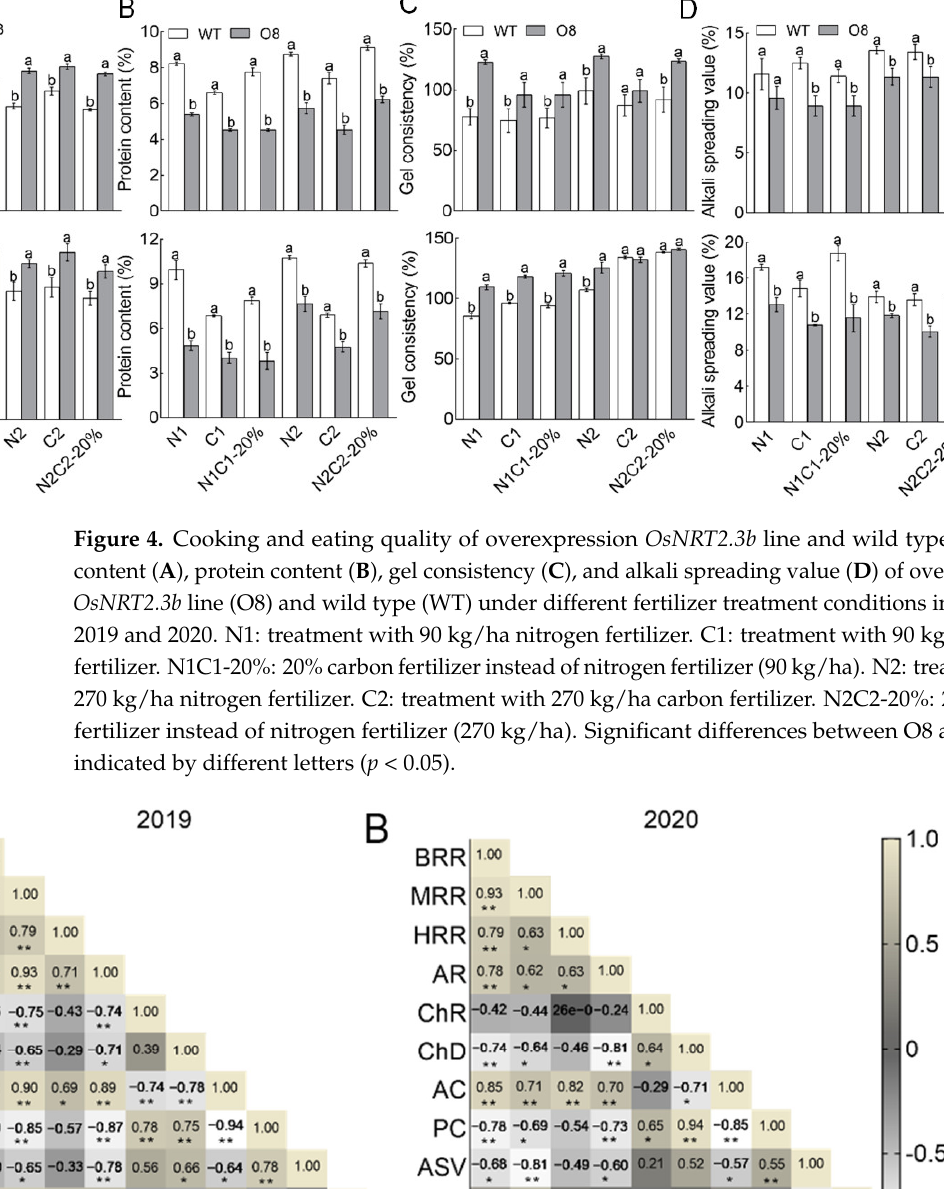
Figure 6. Hierarchical clustering of quality indicators of O8 and WT under different fertilizer treat- ments. Hierarchical clustering of quality indicators of O8 and WT under different fertilizer treat- ment in 2019 ( A ) and 2020 ( B ). BRR, brown rice rate; MRR, milling rice rate; HRR, head milling rice rate; AR, aspect ratio; ChR, chalky rice rate; ChD, chalkiness degree; AC, amylose content; PC, protein content; ASV, alkali seeding value; GC, gel consistency. 4. Discussion Human health requires foods with high nutritional value. Rice is a significant source of carbohydrates, providing at least 20% dietary protein, 3% dietary fat, and other essen- tial nutrients [38]. With the continuous improvement in living standards, improving rice